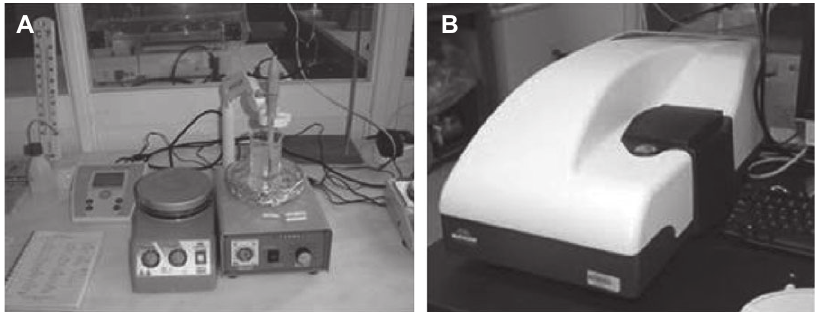
Figure 2 (A) pH measurements and (B) ZP measurements with Zetasizer